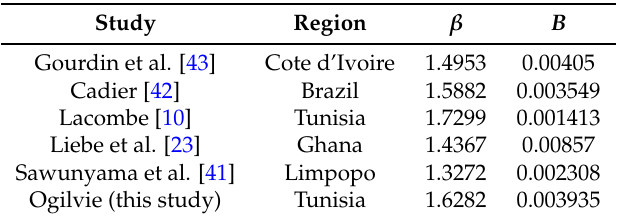
Figure 8. Lake-specific S-V power relations against the interSR power relation (in grey). Table 1. B and β values for S-V power relations for small